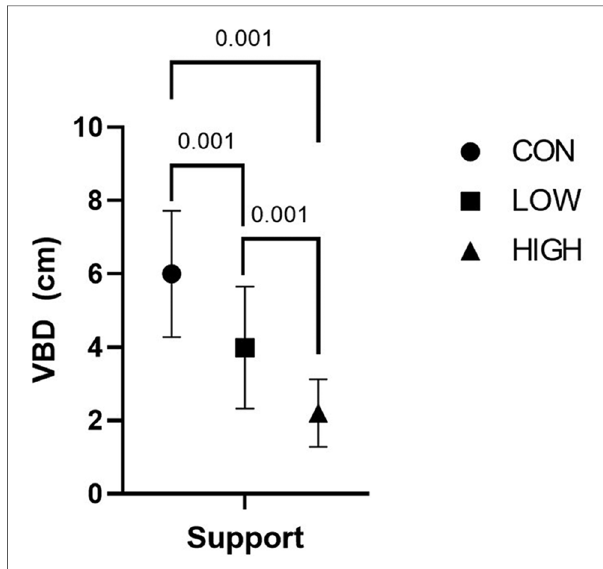
FIGURE 2 Vertical breast displacement (VBD; in cm) for each of the three breast support conditions: CON, LOW and HIGH.